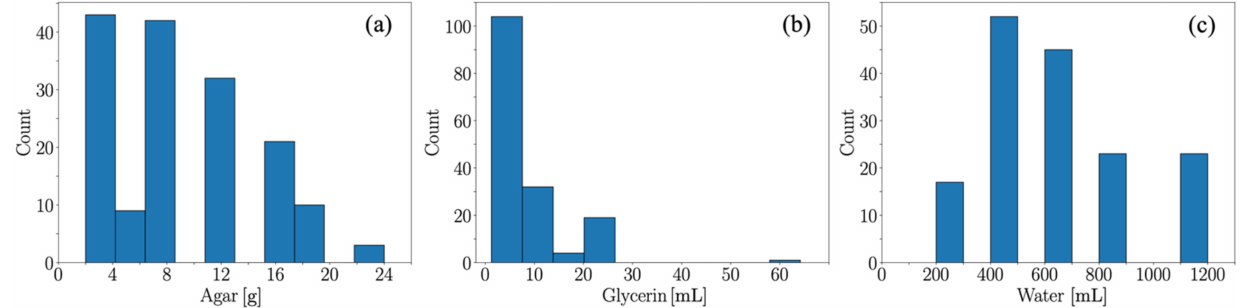
Figure 5. Distributions of ( a ) agar in grams, ( b ) glycerin in mL, and ( c ) water in mL used in the DoE to generate the biopolymer films.